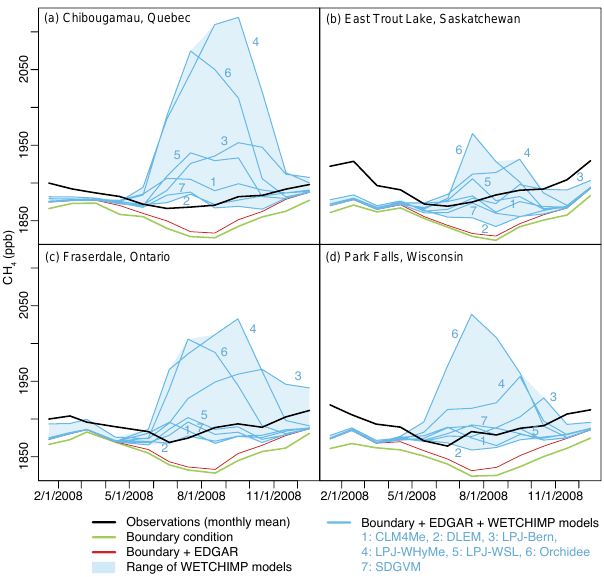
Figure 4. These time series compare atmospheric methane mea- surements at several observation sites against model estimates using the WETCHIMP ensemble and the EDGAR v4.2FT2010 anthro- pogenic emissions inventory. Refer to Fig. S4 for model–data time series at additional sites, particularly sites that are distant from large